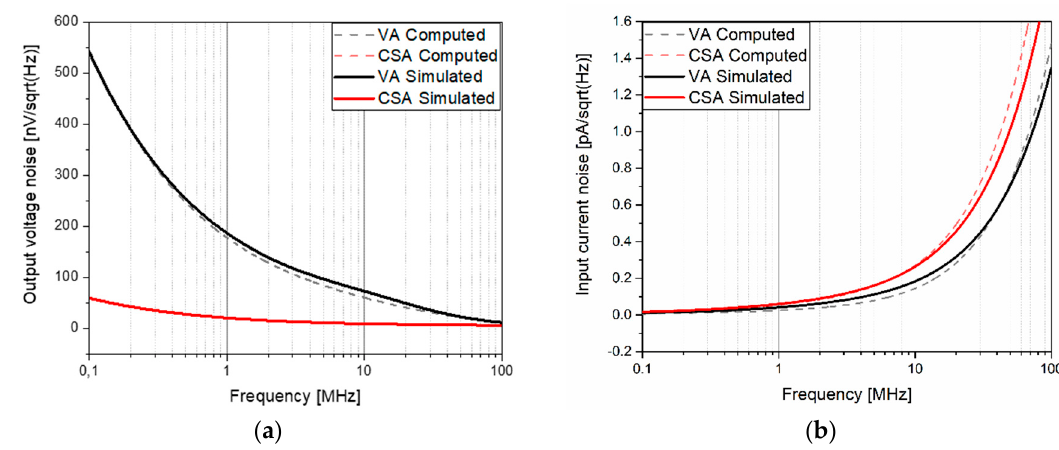
Figure 10. Computations using Equations (2) and (4) and the simulated RX amplifiers’ noise spectral density. ( a ) Output voltage noise and ( b ) input current noise.